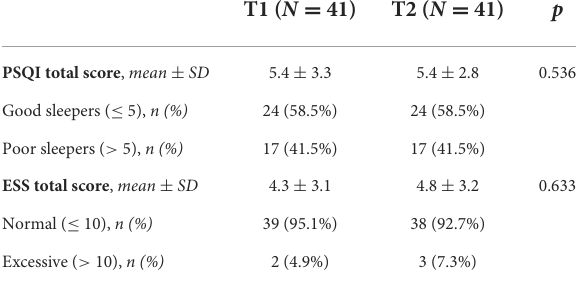
TABLE 2 PSQI and ESS total scores obtained at T1 and T2 study